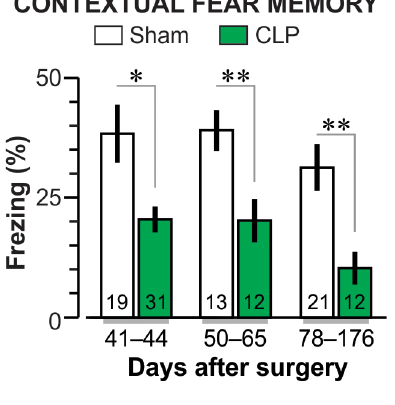
Figure 4. Long-term impairment of contextual fear memory in CLP-exposed mice. Male C57BL/6 mice are subjected to the associative fear conditioning para- digm at different post-surgical time points, and the results are grouped into three intervals. The CLP group shows impairment in the contextual test when compared with the sham group at each time point (* P < 0.05; ** P < 0.01 by t